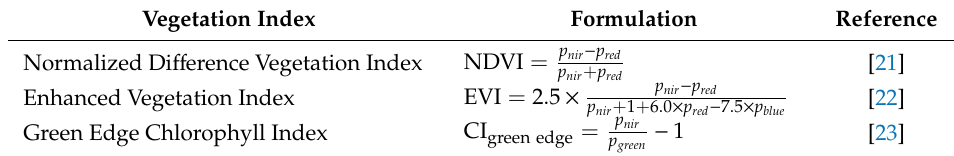
Table 2. Vegetation indices calculated from MODIS 8-day surface reflectance product. Vegetation